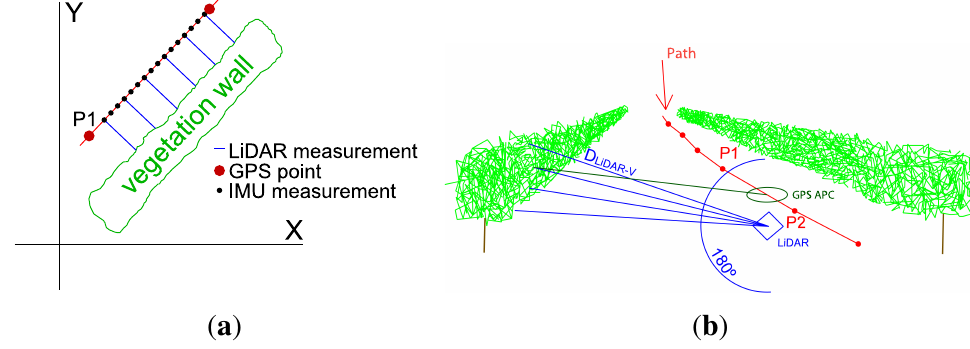
Figure 2. Scheme of sensor measurements in an orchard. The GPS antenna phase center (dark green lines) and LiDAR (blue lines) are separated by a distance. As GPS provides global coordinates of the measurements, the canopy point cloud must be referred to the GPS antenna phase center. ( a ) Measurements in 2D; ( b ) measurements in